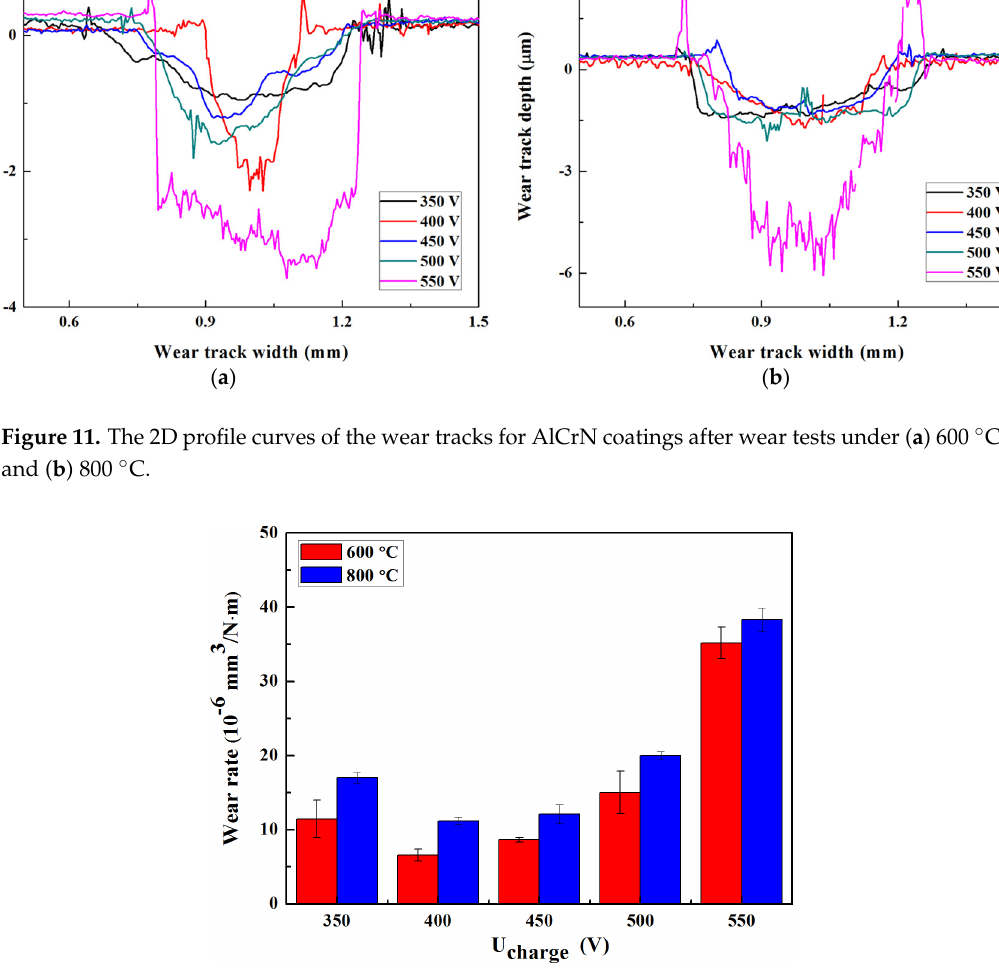
Figure 12. The wear rates of AlCrN coatings deposited at different charge voltages in the pin ‐ on ‐ disk wear tests at 600 °C and 800 °C.